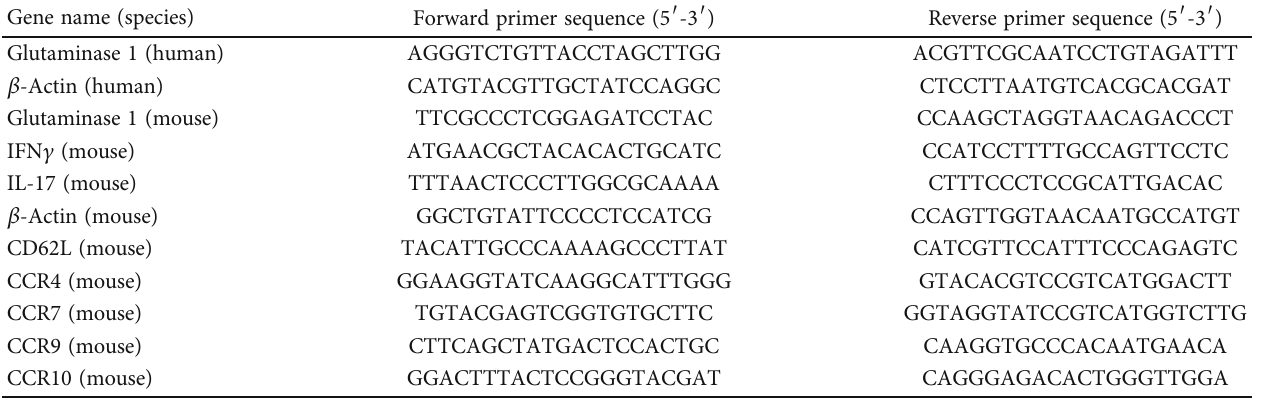
Table 1: Primer sequences of indicated